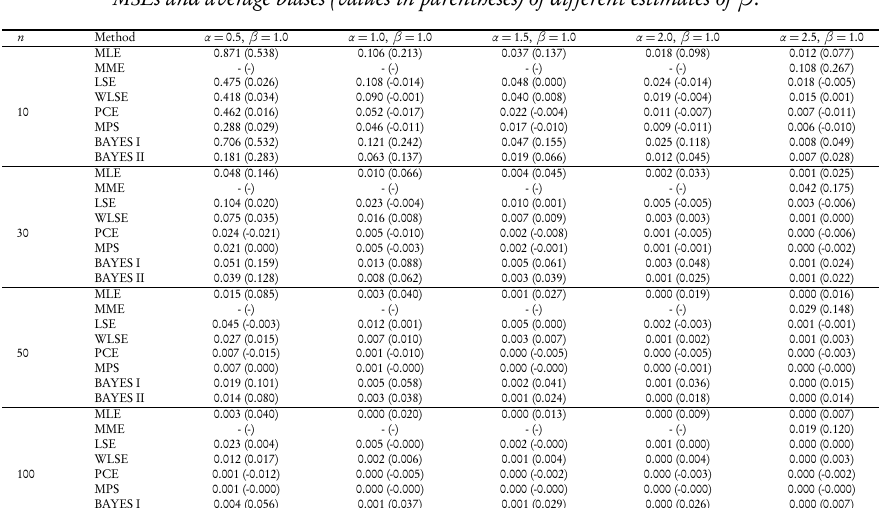
MSEs and average biases (values in parentheses) of different estimates of β